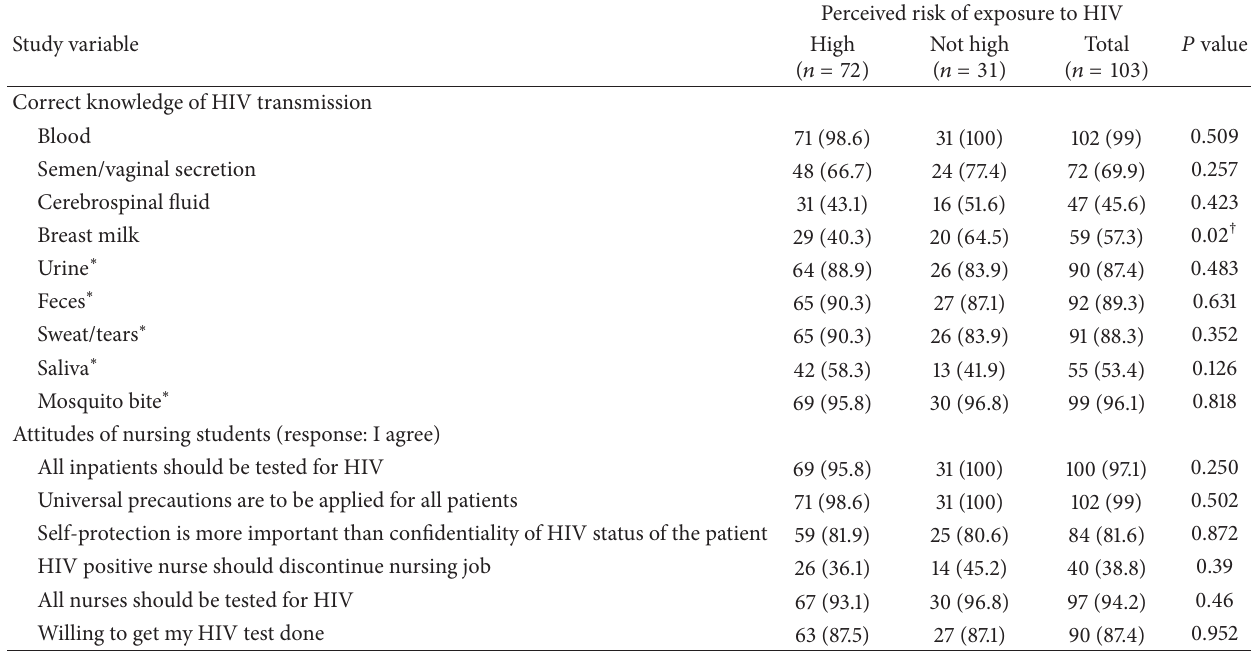
Table 1: Correct knowledge of HIV transmission and attitudes of nursing students according to their perceived risk of exposure to HIV in nursing profession.